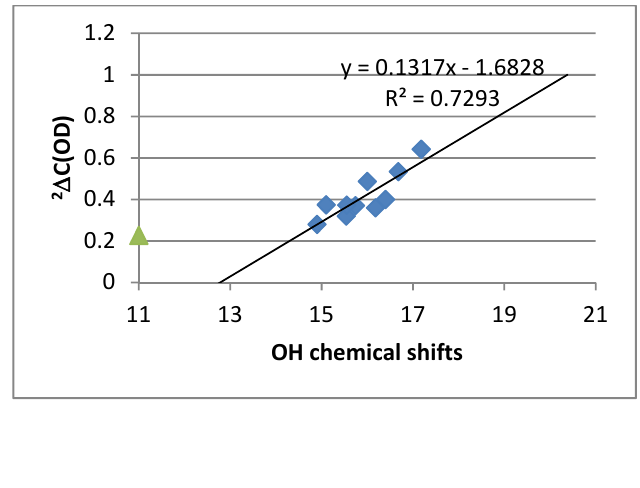
Figure 4. Plot of 2  C(OD) vs. OH chemical shifts. Green triangle is data for